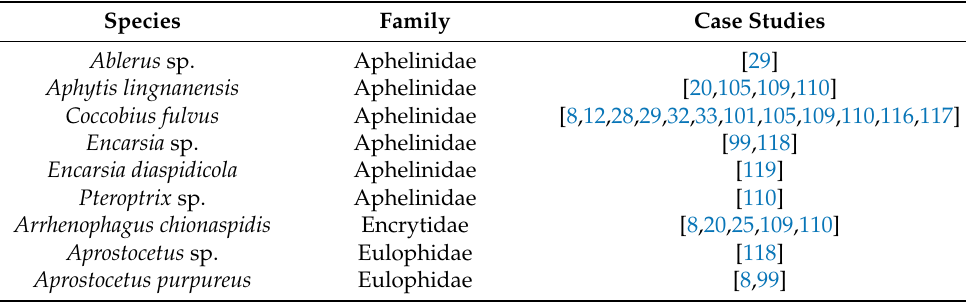
Table 4. A list of parasitoids known to parasitize Aulacaspis yasumatsui